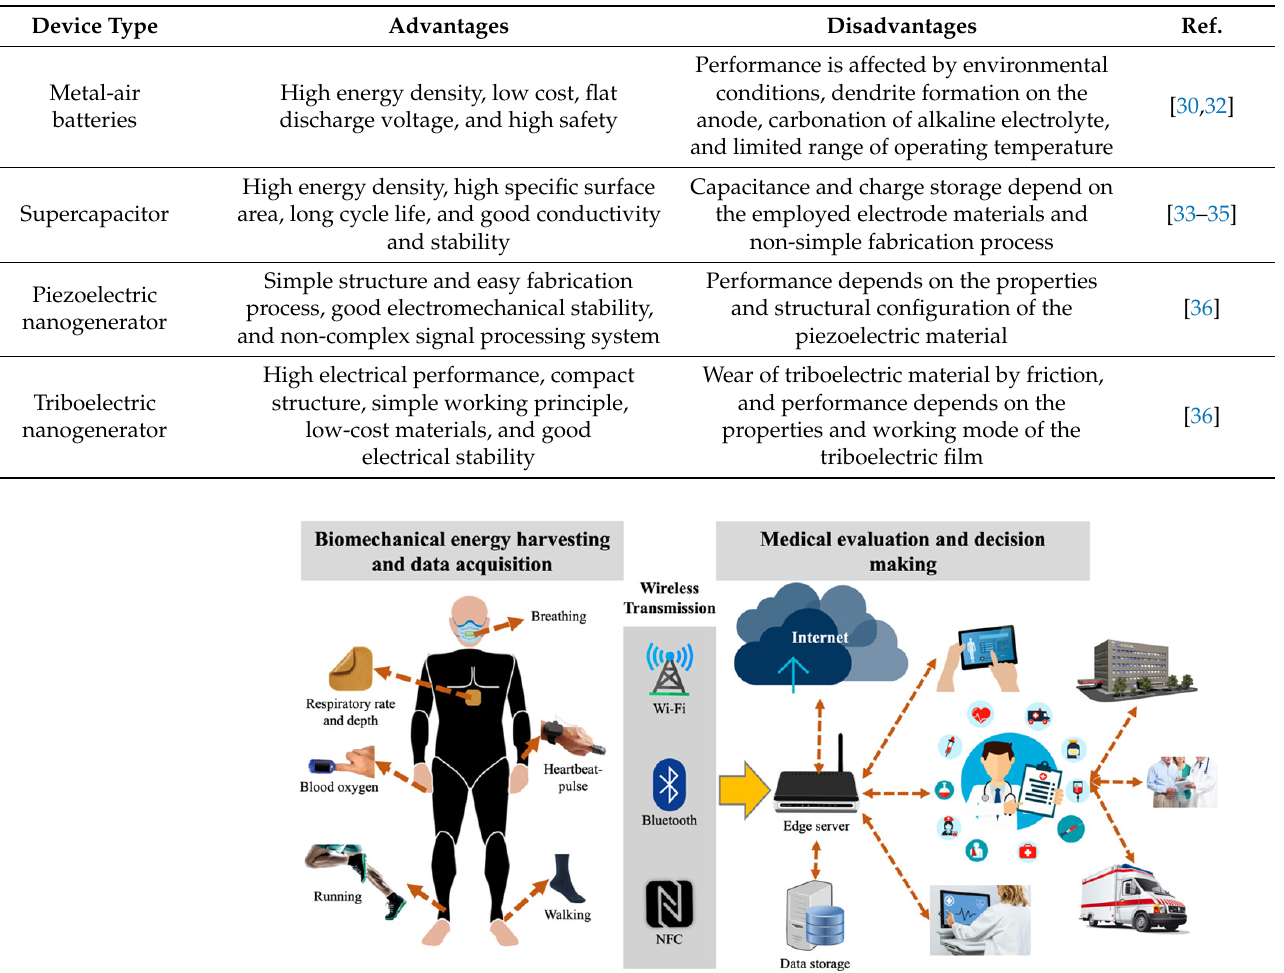
Figure 1. Potential application of piezoelectric and triboelectric nanogenerators to convert biome-